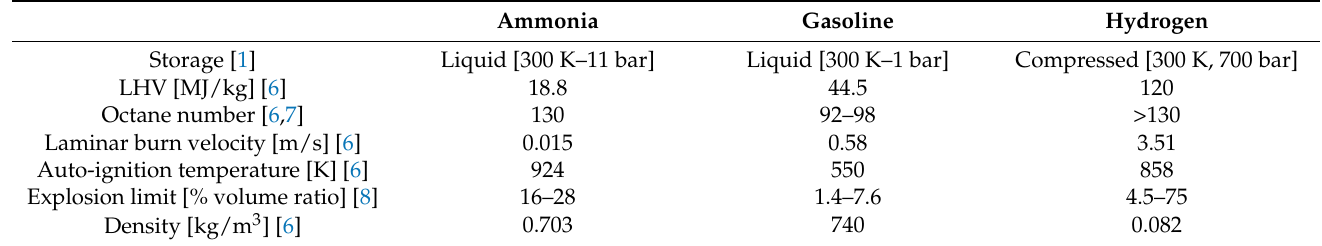
Table 1. Ammonia properties vs. gasoline and hydrogen